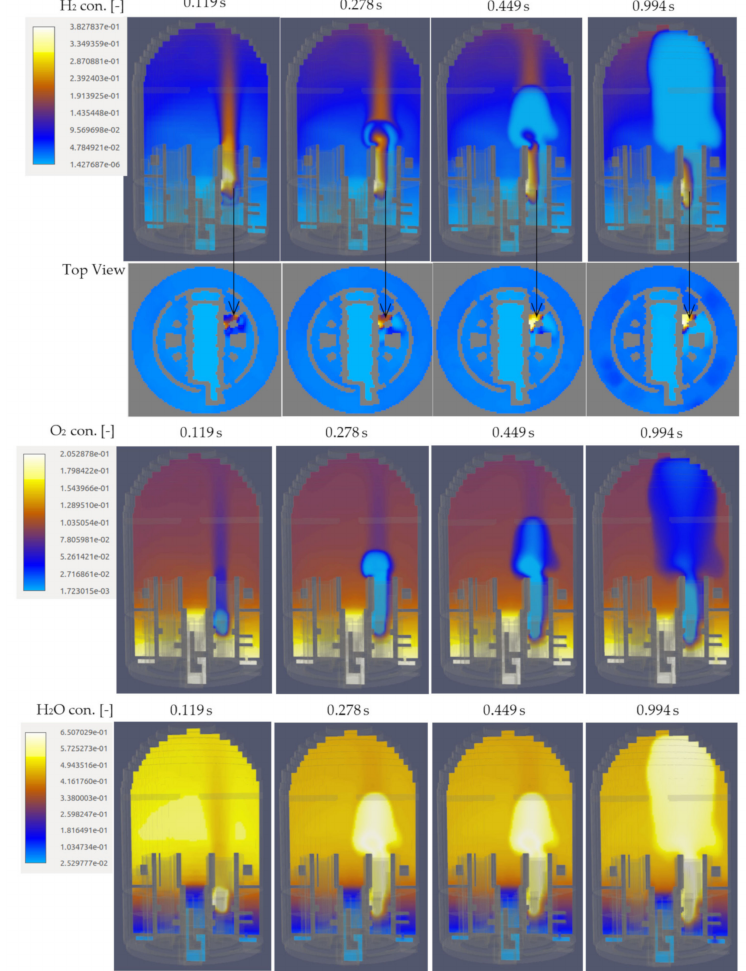
Figure 10. Calculated concentrations of hydrogen, oxygen, and steam, according to time